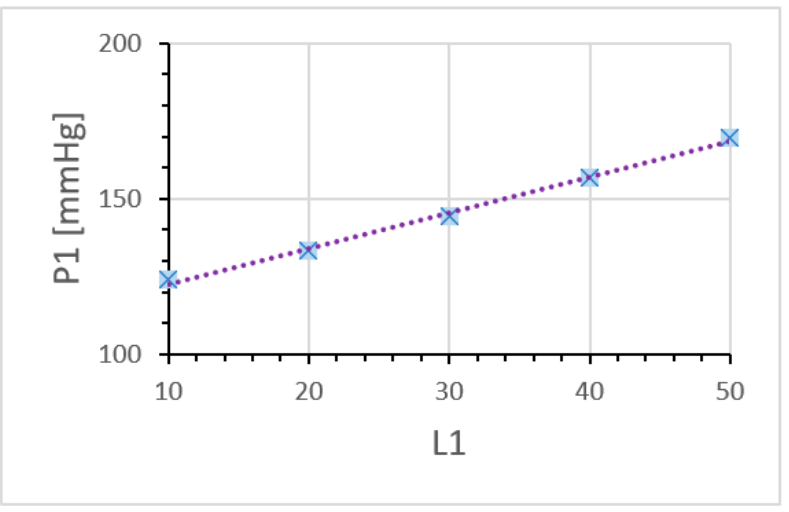
Figure 5. Maximum value of the local blood pressure P 1 depending on the aneurysmal compliance L 1 . The daughter aneurysms are not assumed to be formed well ( C 2 = 0.1, C 2 = 0.001, L 2 = 0). By changing the compliance parameter L 1 of mother aneurysm, the local pressure P 1 of mother aneurysm increases linearly. Note that the blood flow F – F 1 and blood pressure P in the parent artery is nothing different from those given by Figure